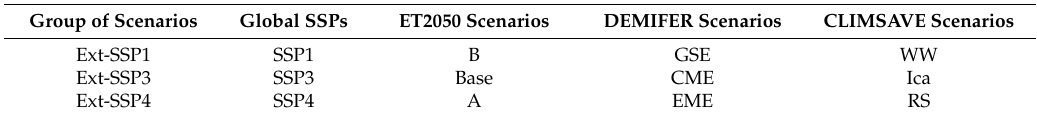
Table 2. Groups of scenarios sharing similar storylines, matched with the scenario matching approach [5]. Each group constitutes a given extended SSP